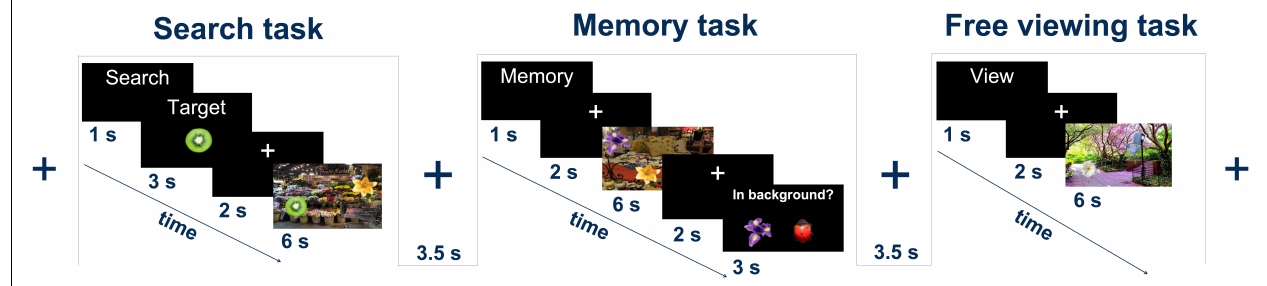
FIGURE 1 | Experimental tasks: the search task, the memory task, and the free viewing task. In all tasks, a natural scene image with five foreign objects was presented for 6 s. Figure adapted from Jo et al. (2019a).